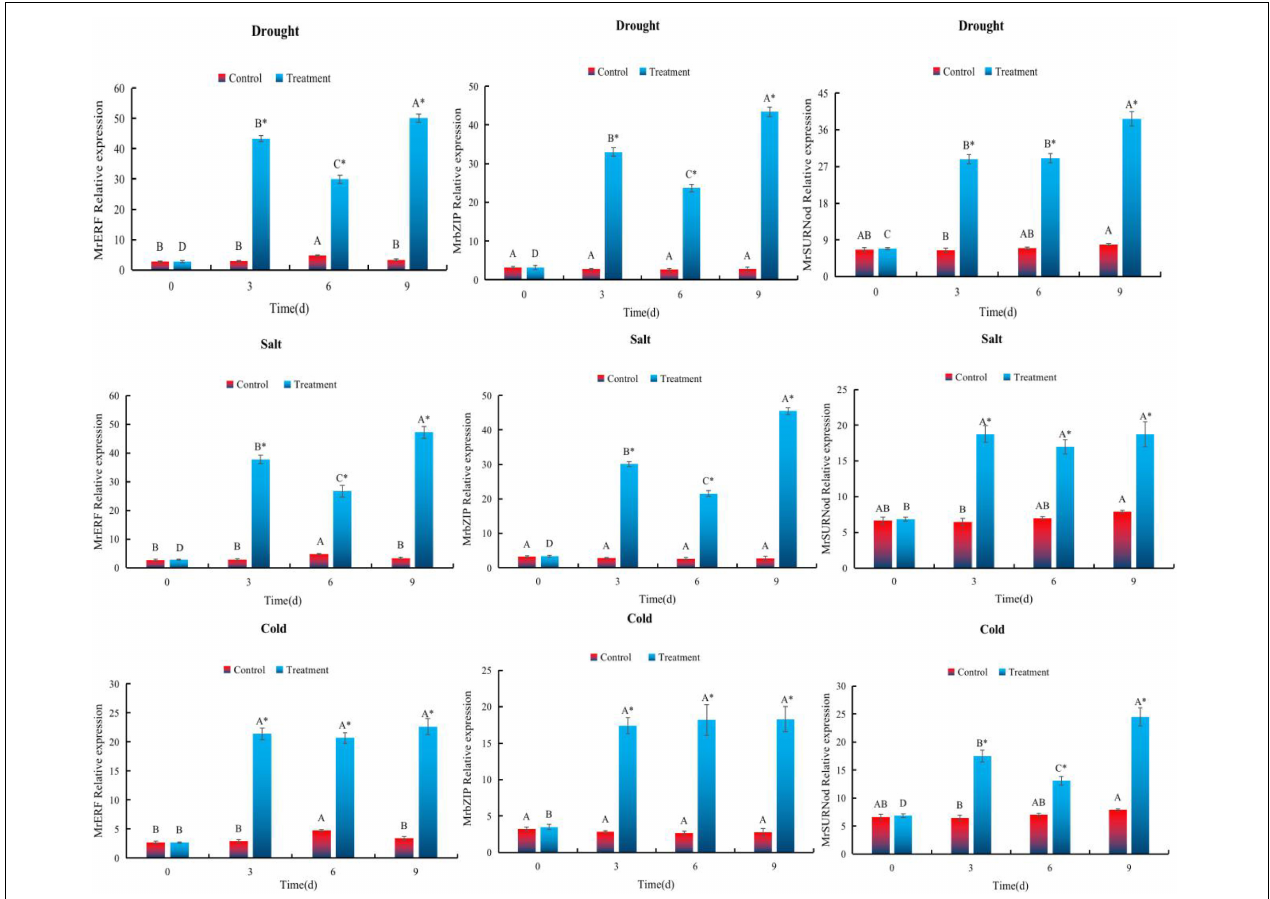
FIGURE 5 | Expression patterns of MrERF , MrbZIP, and MrSURNod in leaf under abiotic stress. Different capital letters indicate significant differences under different treatments, and “ ∗ ” indicates significant differences between control and treatment ( P <